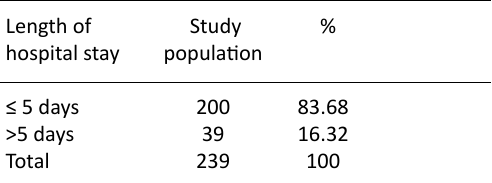
Table 3. Length of hospital stay in In-patients Length of